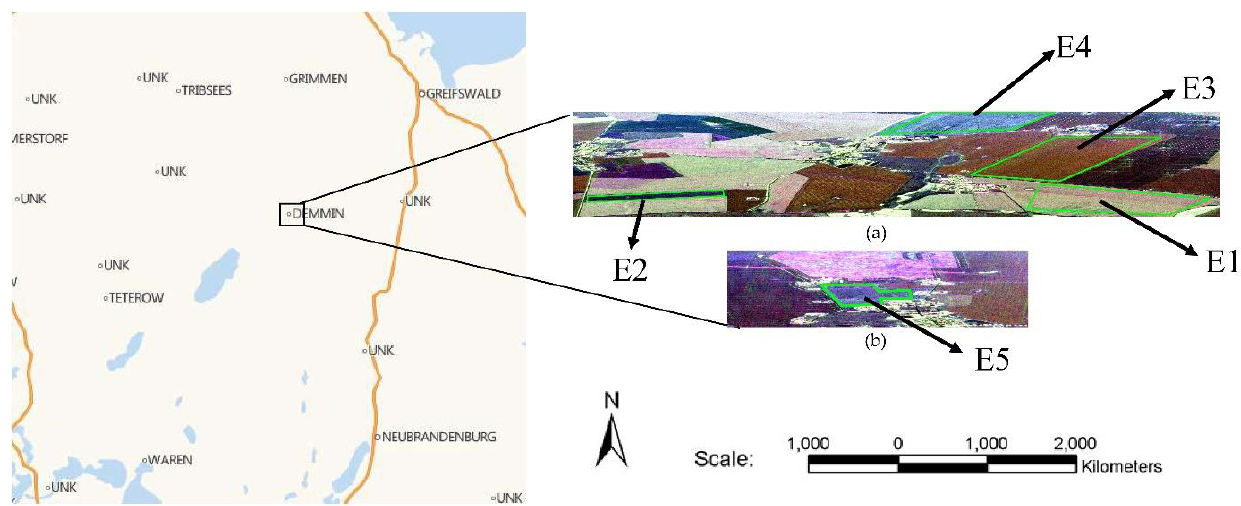
Figure 3. The generated simulated data’s ground truth.